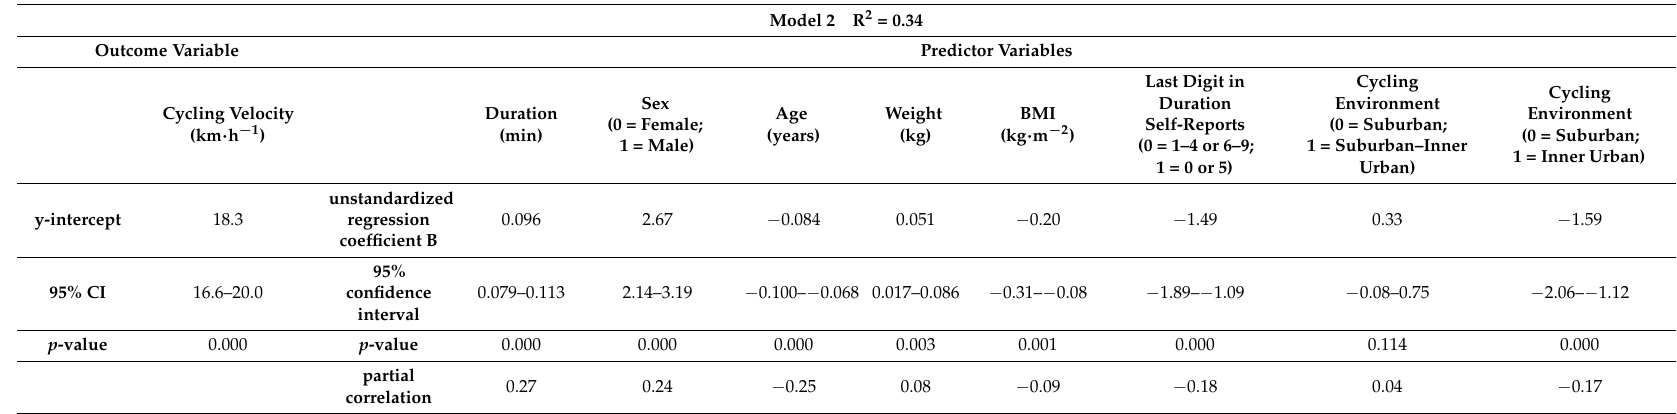
Table 5. Multiple regression analyses of the relation between cycle commuting speed and duration as well as other predictors. All calculations are based on self-reported durations of ≤ 50 min ( n =